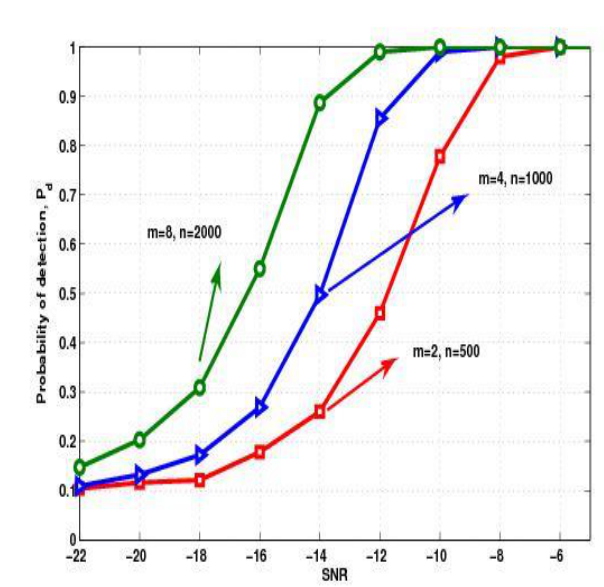
Figure 4. Probability of detection vs SNR for EME.